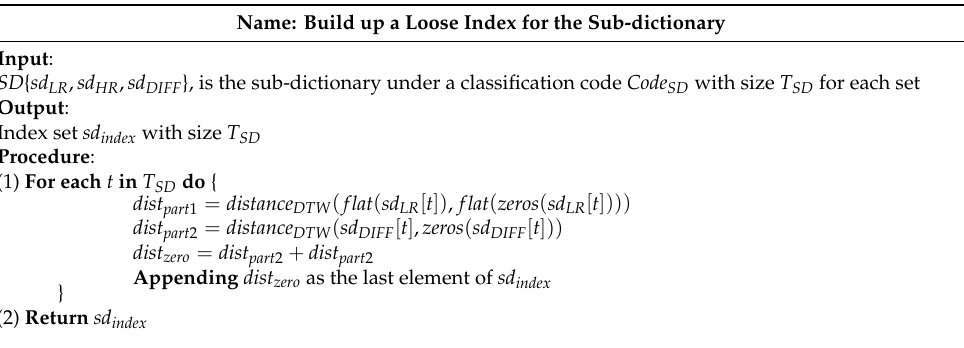
Table 7. The sub-dictionary loose indexing algorithm.